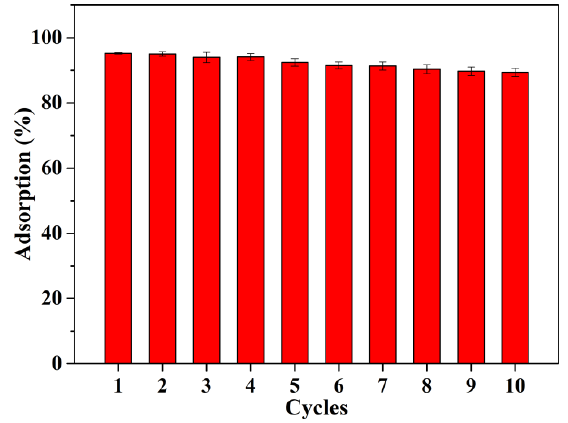
Figure 9. Adsorption ability of the Alg-Mel in ten adsorbing-desorbing cycles.